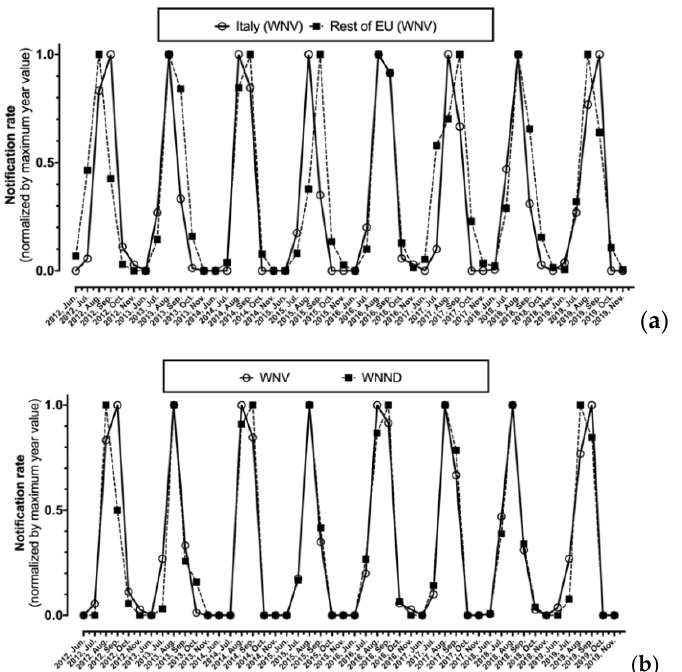
Figure 3. Monthly notification rate of West Nile virus (WNV) diagnoses normalized by maximum value for Italy compared to the rest of European Union ( a ), of all new diagnoses of WNV compared to corresponding new diagnoses of West Nile neuro-invasive disease (WNND) cases in Italy alone ( b ). As shown in Table 2, crude incidence rates for WNV infections ranged from